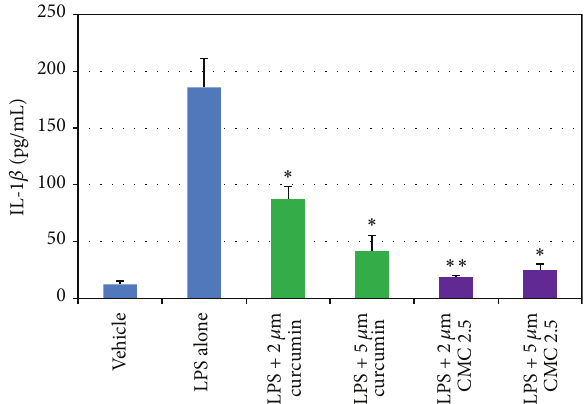
Figure 2: Inhibition of IL-1 𝛽 levels by curcumin and CMC 2.5 in PBMC cells. PBMC cells (5 × 10 5 cells/well) were cultured in serum-free media (37 ∘ C, 95% air, 5% CO 2 ) for 18 hours with LPS ( P. gingivalis , 50ng/mL) or vehicle alone. Curcumin or CMC 2.5 was addedatfinalconcentrationsof2or5 𝜇 M.Conditionedmediumwas analysed for IL-1 𝛽 by ELISA. Each value represents the mean of 3 cultures ± S.E.M. ∗ 𝑃 < 0.05 represents the significance of all groups of curcumin and CMC 2.5 compared to LPS alone; ∗∗ 𝑃 < 0.05 representsthesignificancebetweenLPS+2 𝜇 McurcuminandLPS + 2 𝜇 M CMC 2.5.